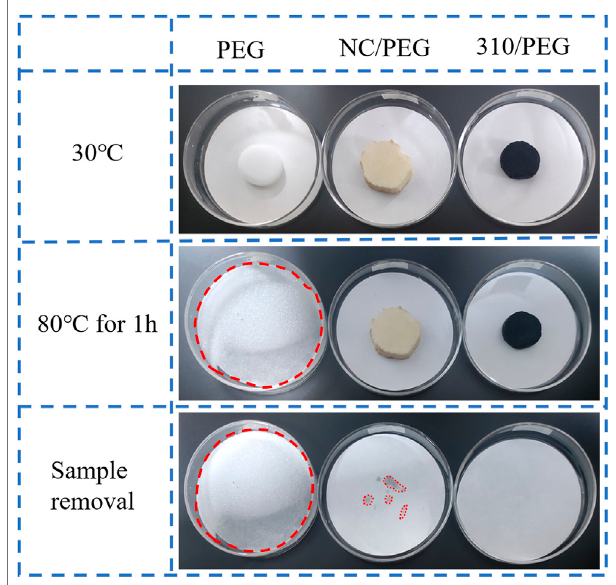
FIGURE 1 | The photographs of PEG, NC/PEG, and 310/PEG composites were heated at 80 ° C for 1